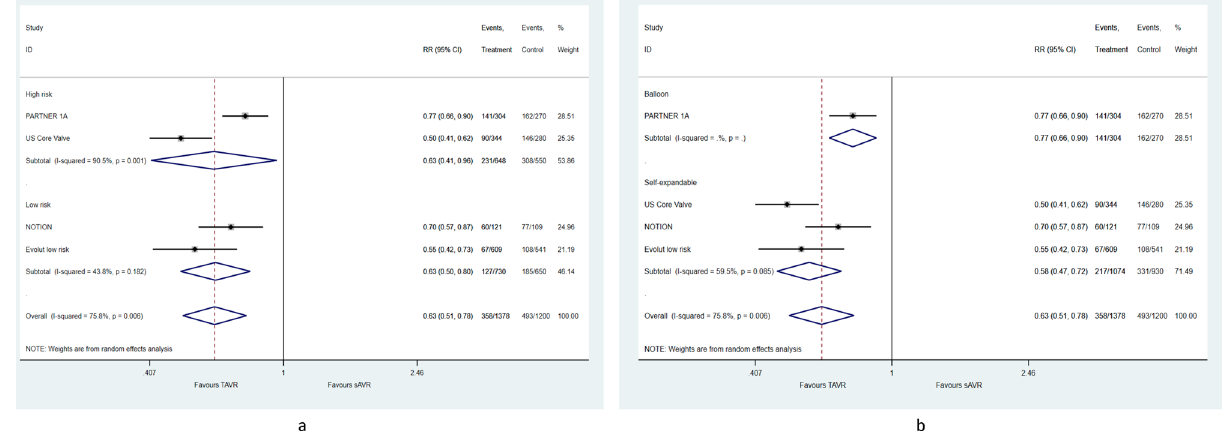
Figure 2. Pooled mean difference of post-procedural patient-prosthesis-mismatch, according to ( a ) surgical risk on inclusion and ( b ) transcatheter heart valve system.